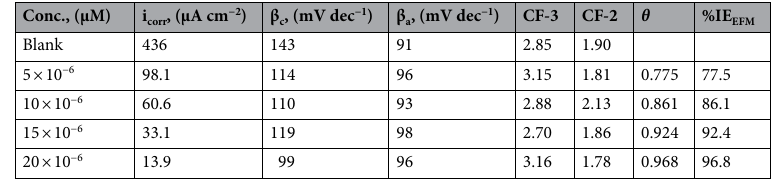
Table 2. EFM kinetic parameters of DTG